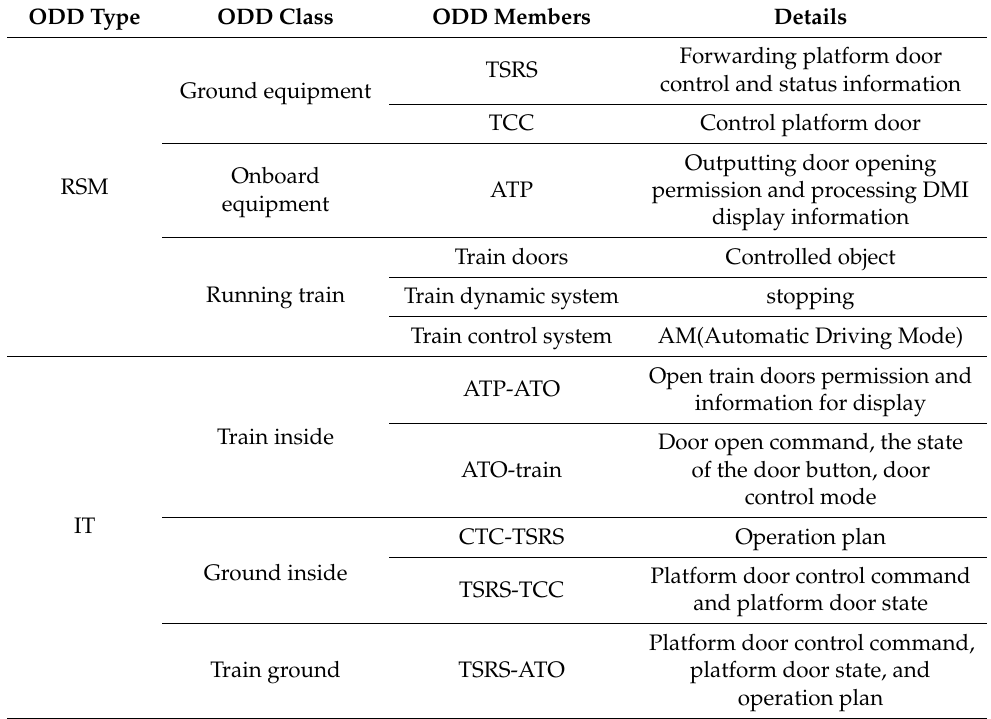
Table 2. ODD members of the linkage control